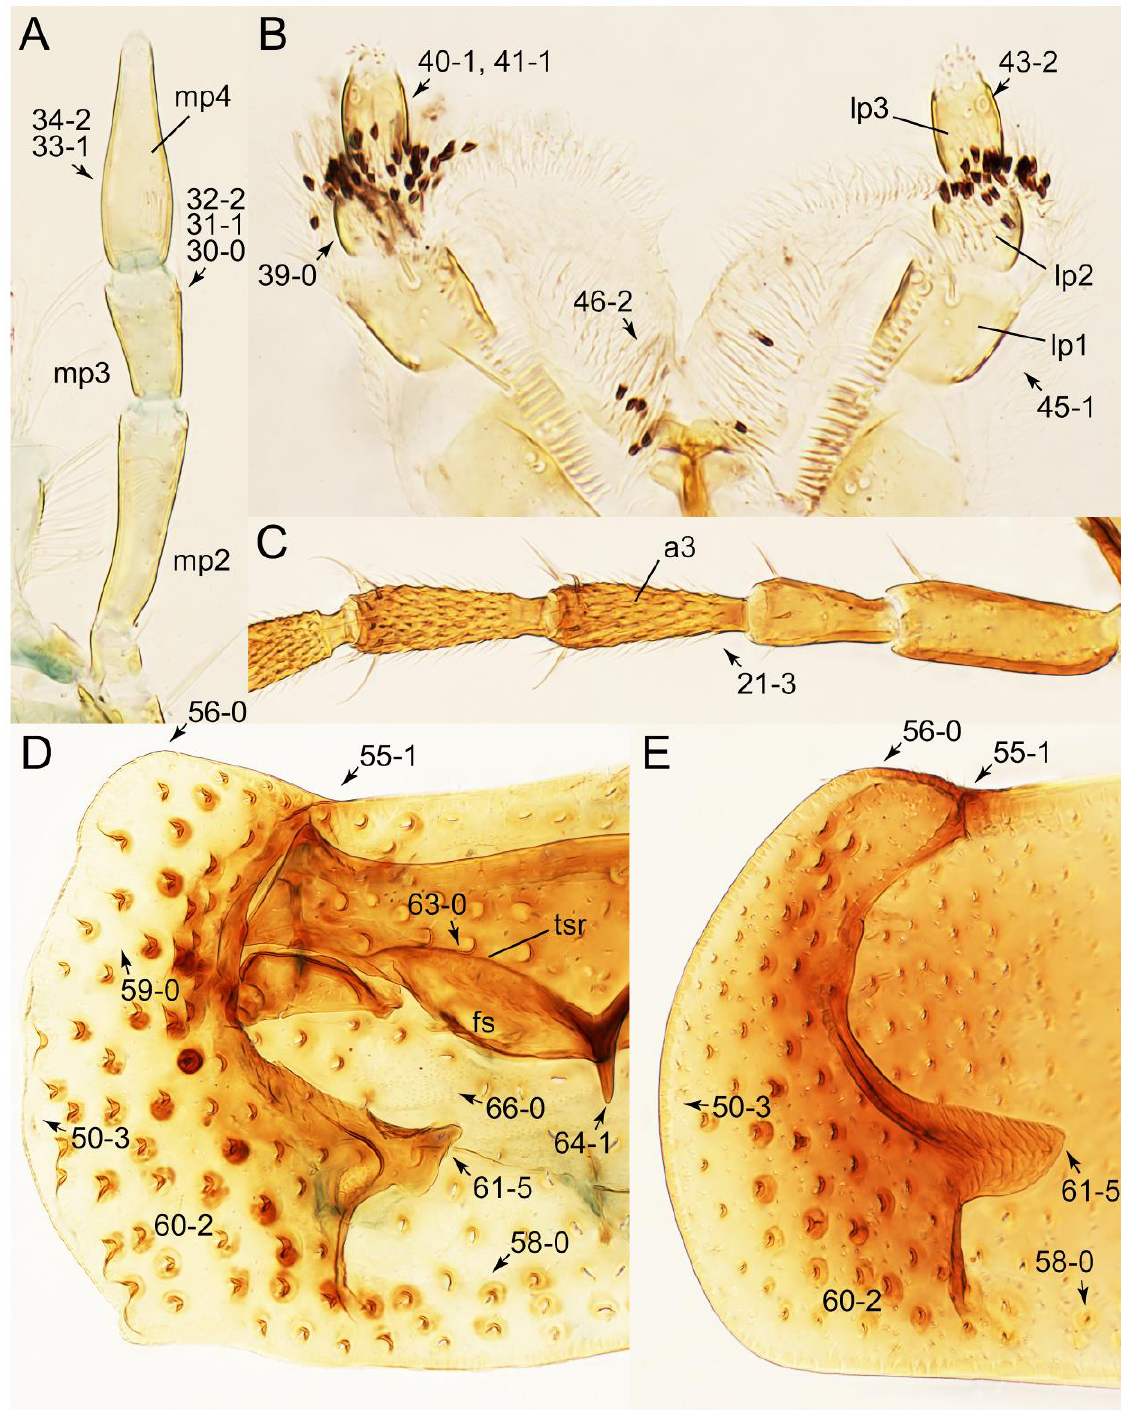
Figure 59. Photographs of body parts of Tachinusini: members of the former Megarthropsini, enlarged. ( A ) left maxillary palpus of Megarthropsis decorata , ventral view. ( B ) labium of Lacvietina takashii , ventral view. ( C ) basal half of right antenna of Lacvietina takashii , dorsal view. ( D ) prosternum and pronotum of Megarthropsis decorata , ventral view. ( E ) pronotum of Lacvietina takashii , ventral view. Abbreviations: a3, antennomere 3; fs, furcasternum; lp1–3, labial palpomere 1–3; mp2–4, maxillary palpomere 2–4; tsr, transverse sternacoxal ridge of prosternum. Characters and character states (format X-X) are indicated on each